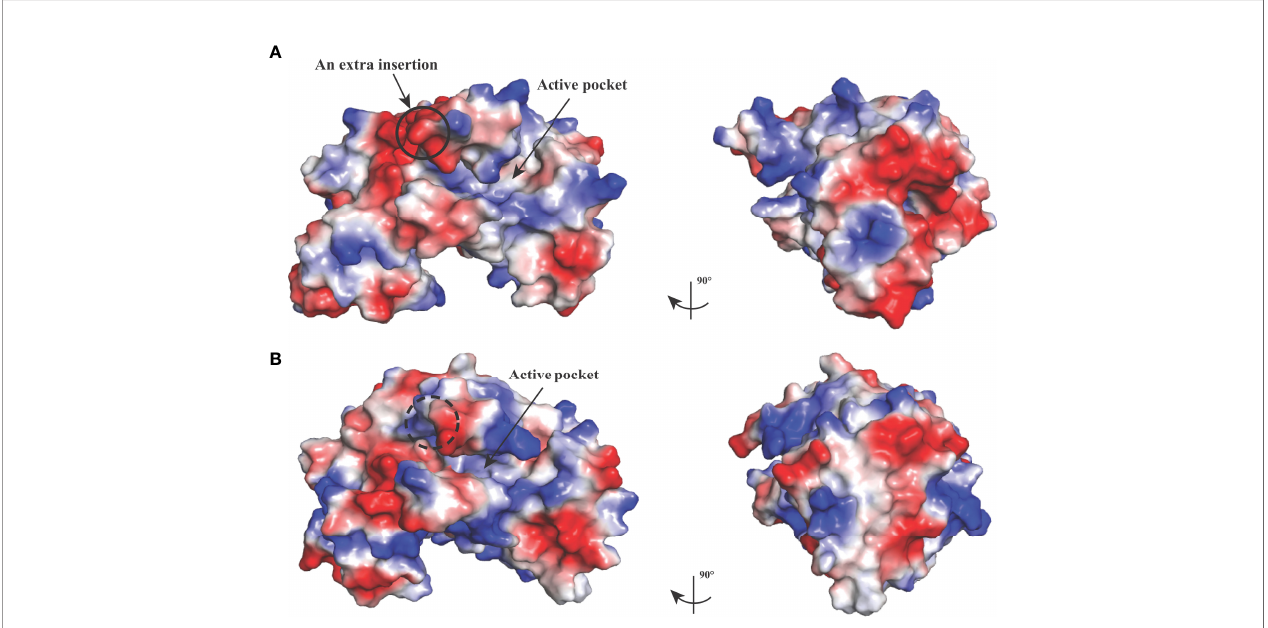
FIGURE 5 | Electrostatic surface potential of BoLDH structure. The crystal structure of BoLDH (A) and BmLDH (B) in identical orientations are displayed as a molecular surface model colored according to electrostatic potential, and the red regions for negative charge and the blue regions for positive charge are labeled, respectively. Black solid circle indicated the extra insertion of BoLDH, and black dashed circle displayed the corresponding position in BmLDH. The maximum and minimum eV values for the electrostatic map are 64.635 and -64.635,